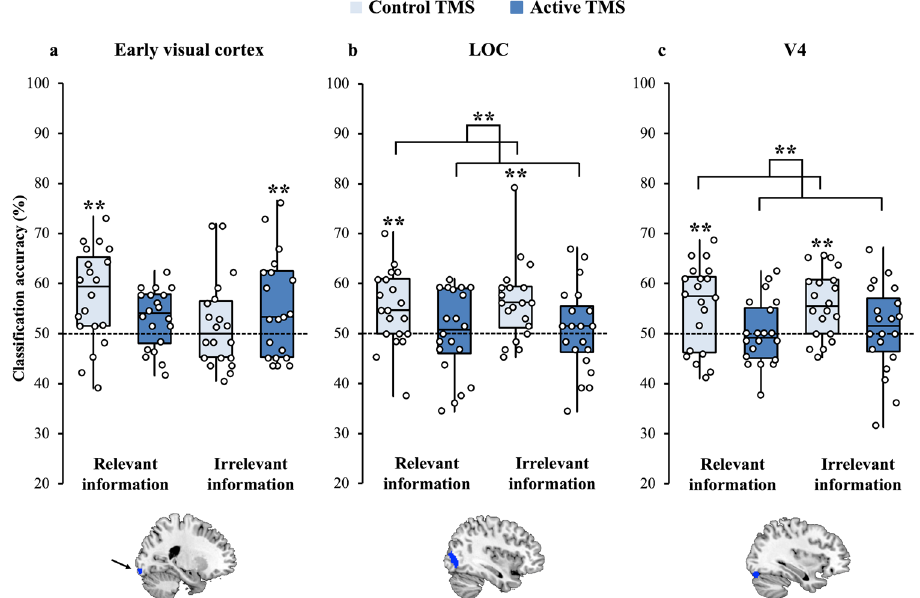
Fig. 6 Coding in visual ROIs under Control and Active TMS. Box plot summary depicting the minimum and maximum values, the lower and upper quartiles and the median scores. Individual data points indicated by open circles. Lighter-coloured bars depict coding under control TMS, and darker- coloured bars depict coding under Active TMS trials. a Early visual cortex (central visual fi eld). This ROI was derived from individual-participant localiser data and de fi ned as the region stimulated by visual information at fi xation (encompassing the same area of the central visual fi eld as the objects in the main experimental task) minus visual information outside fi xation. There were no signi fi cant main effects or interactions. b Lateral occipital complex (LOC). This ROI was derived from localiser data as the region more active for viewing of whole objects over scrambled objects. There was stronger coding under the Control TMS condition compared to the Active condition modulated by a Feature × TMS interaction re fl ecting a stronger effect of TMS on colour than form coding. c V4. This ROI was derived from coordinates from the literature 120 and transformed into native space for each participant. There was again the main effect of TMS modulated by a Feature × TMS interaction re fl ecting a stronger effect of TMS on colour than form coding. Signi fi cance markings for individual bars indicate whether coding was signi fi cantly greater than chance in each condition separately (by permutation). * P < 0.05; ** P < 0.01. N = 20